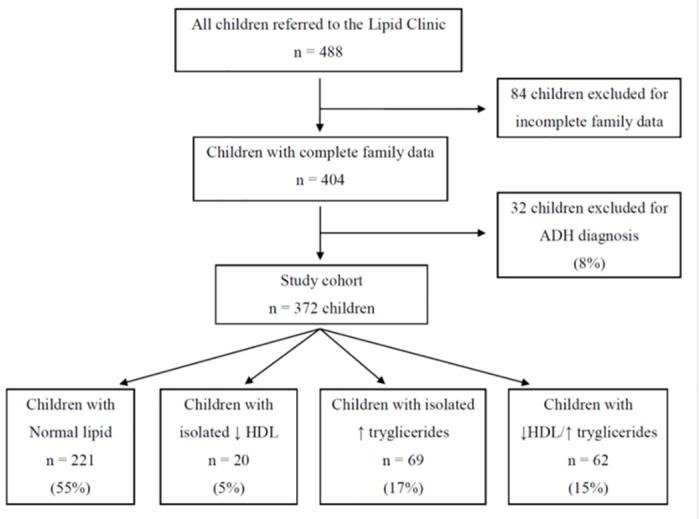
Flow diagram for classification of children with atherogenic dyslipidemia.